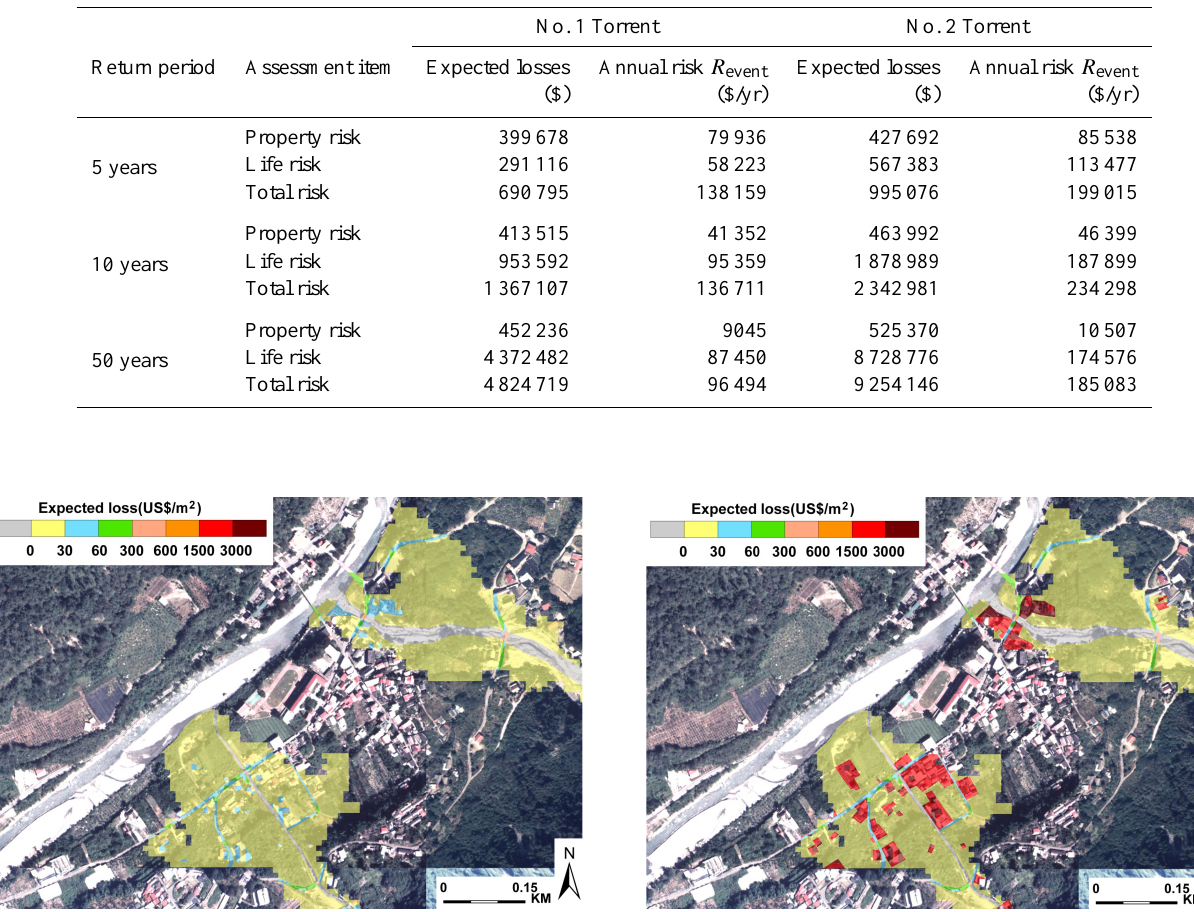
Table 4. Expected losses and annual risk of debris flows for Nos. 1 and 2 Torrents.